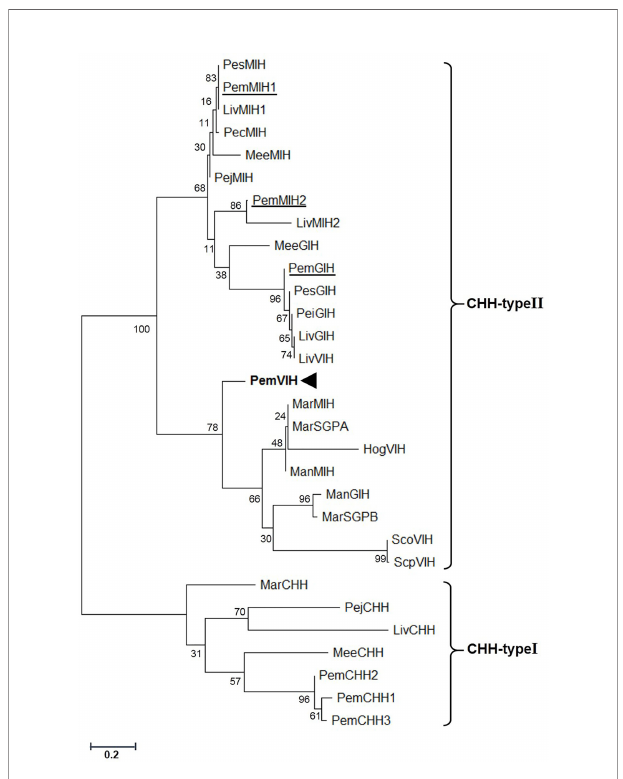
FIGURE 2 | Phylogenetic analysis of PemVIH and other crustacean CHH superfamily members. The number of each node showed bootstrap values generated by the Maximum Likelihood method (1,000 replication). Species of origin for CHH-type I and CHH-type II are included in the abbreviated names (see Table 2 ) on the right side. PemVIH is indicated in bold, whereas other CHH-type IIs in P. monodon are